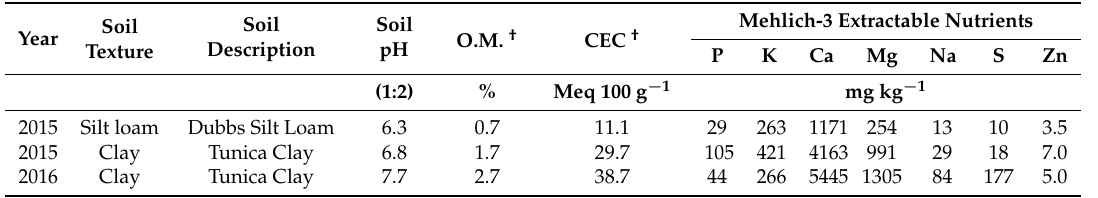
Table 1. Selected soil chemical properties of research fields used for studies in Stoneville, MS in 2014 and